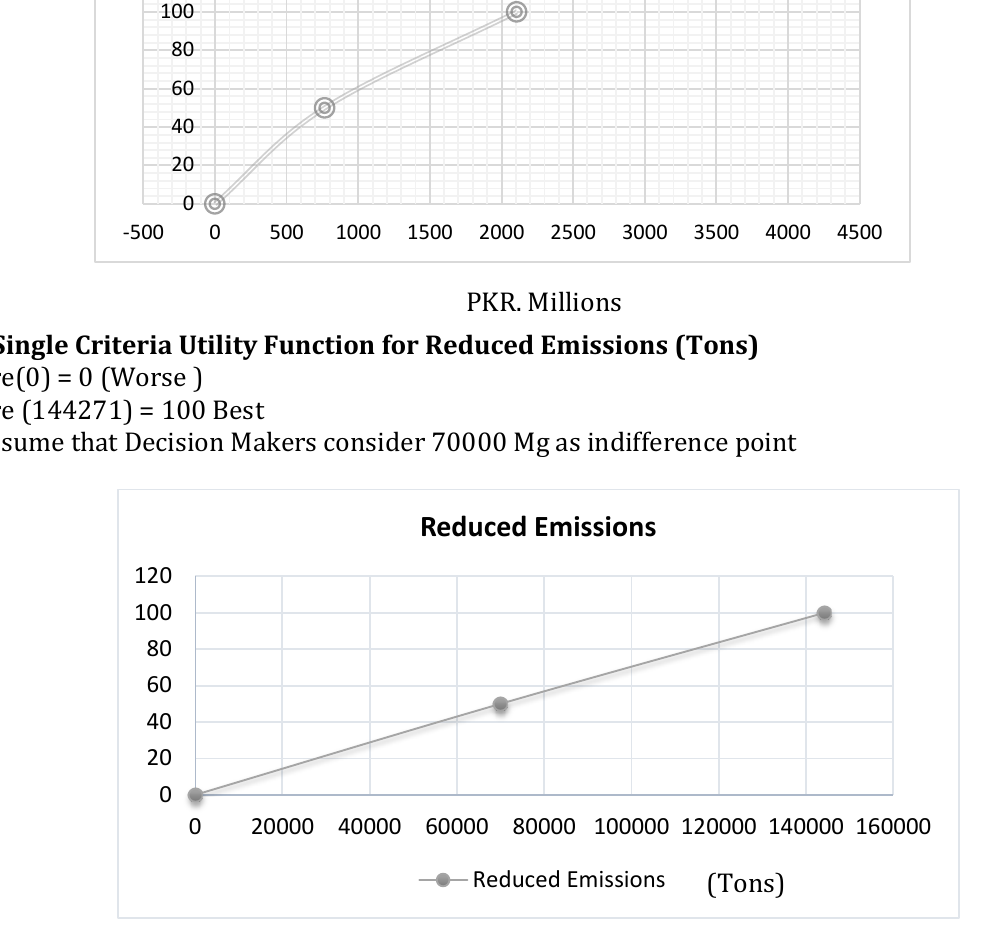
Table 8: Scaled Values for Each Performance Criteria